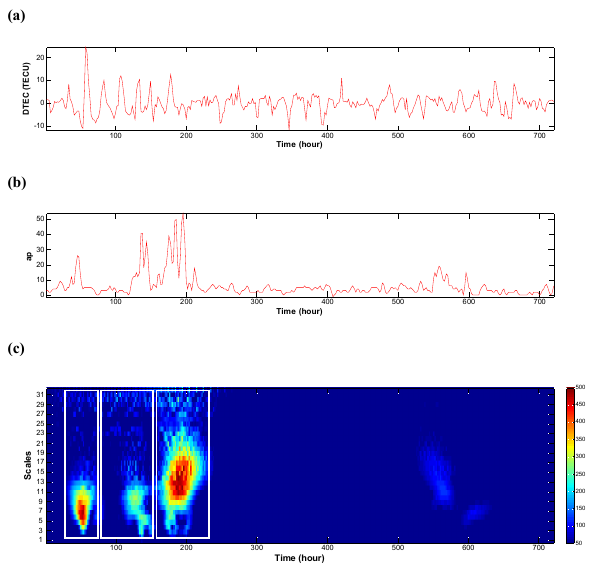
Figure 7. (a) The DTEC time series right over the epicenter (30.3° N, 103.0° E) of the Ya’an earthquake from 22 March 2013 to 20 April 2013. (b) The variations of the ap geomagnetic index from 22 March 2013 to 20 April 2013. (c) The cross-wavelet spectrum for DTEC and ap using fbsp2-1-0.5 wavelet.